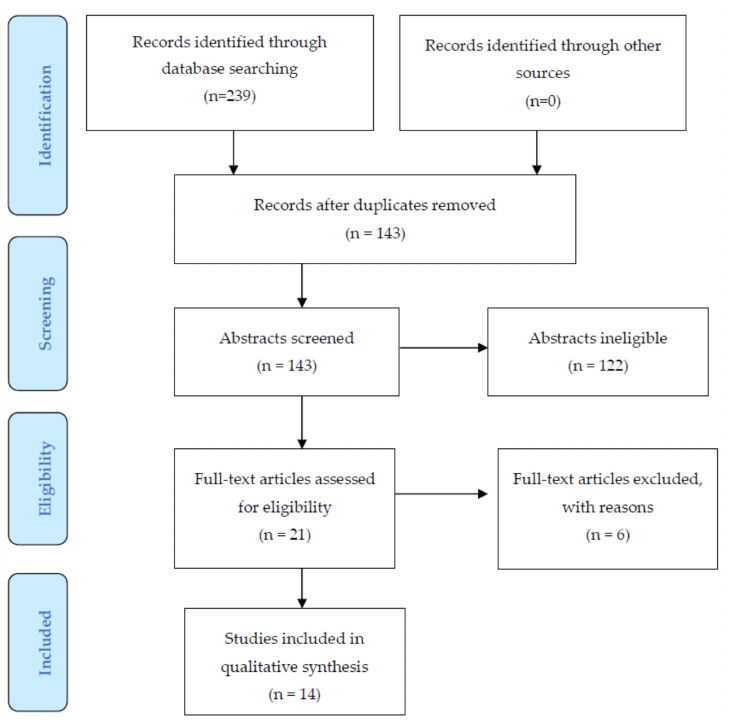
Figure 1. Flowchart for selection of